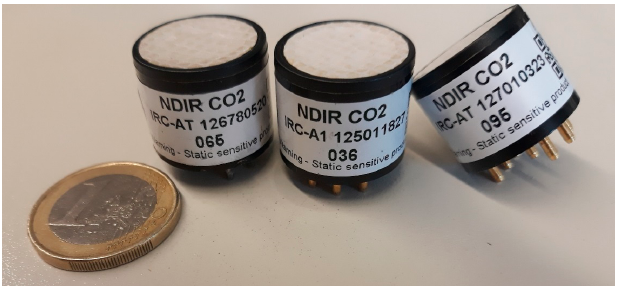
Figure 7. Alphasense offers miniature NDIR cells for CO 2 detection in 20-mm diameter compact systems.